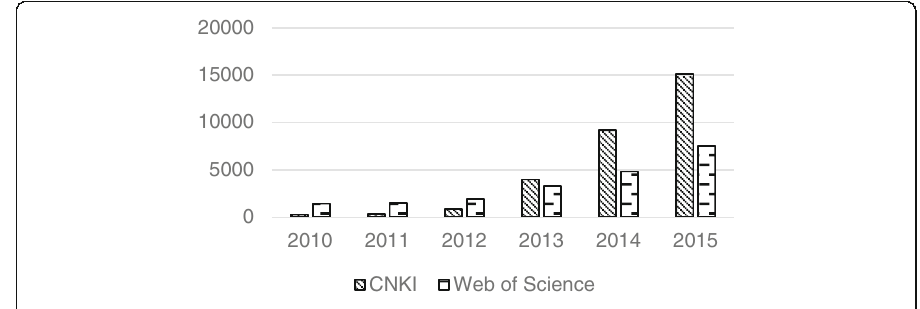
Fig. 1 Number of papers published in 2010 – 2015 with “ big data ” as the